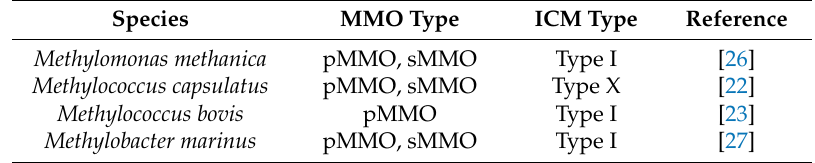
Table 1. ICM (intracytoplasmic membrane) types and MMO (sMMO, pMMO) types for major species.